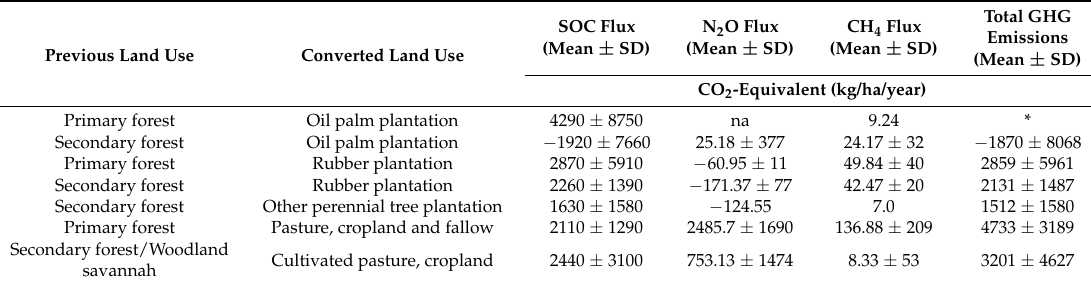
Table 3. Total GHG emissions (CO 2 e kg/ha/year) following land use change from tropical mineral soils (data source: Table 2 for SOC and Tables S5–S10 for N 2 O and CH 4